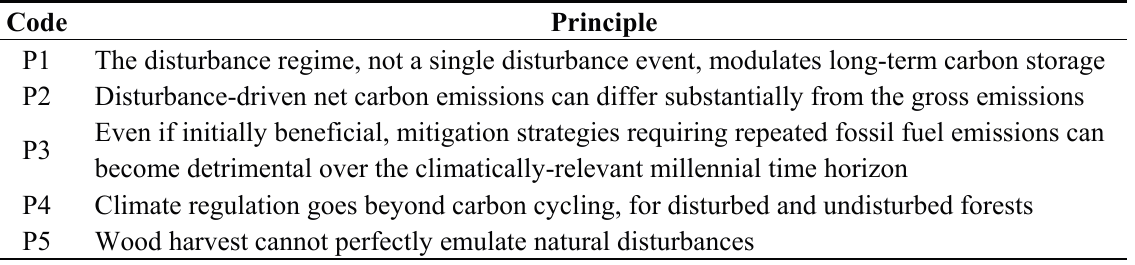
Table 1. Five scientific principles relevant for Canadian managed